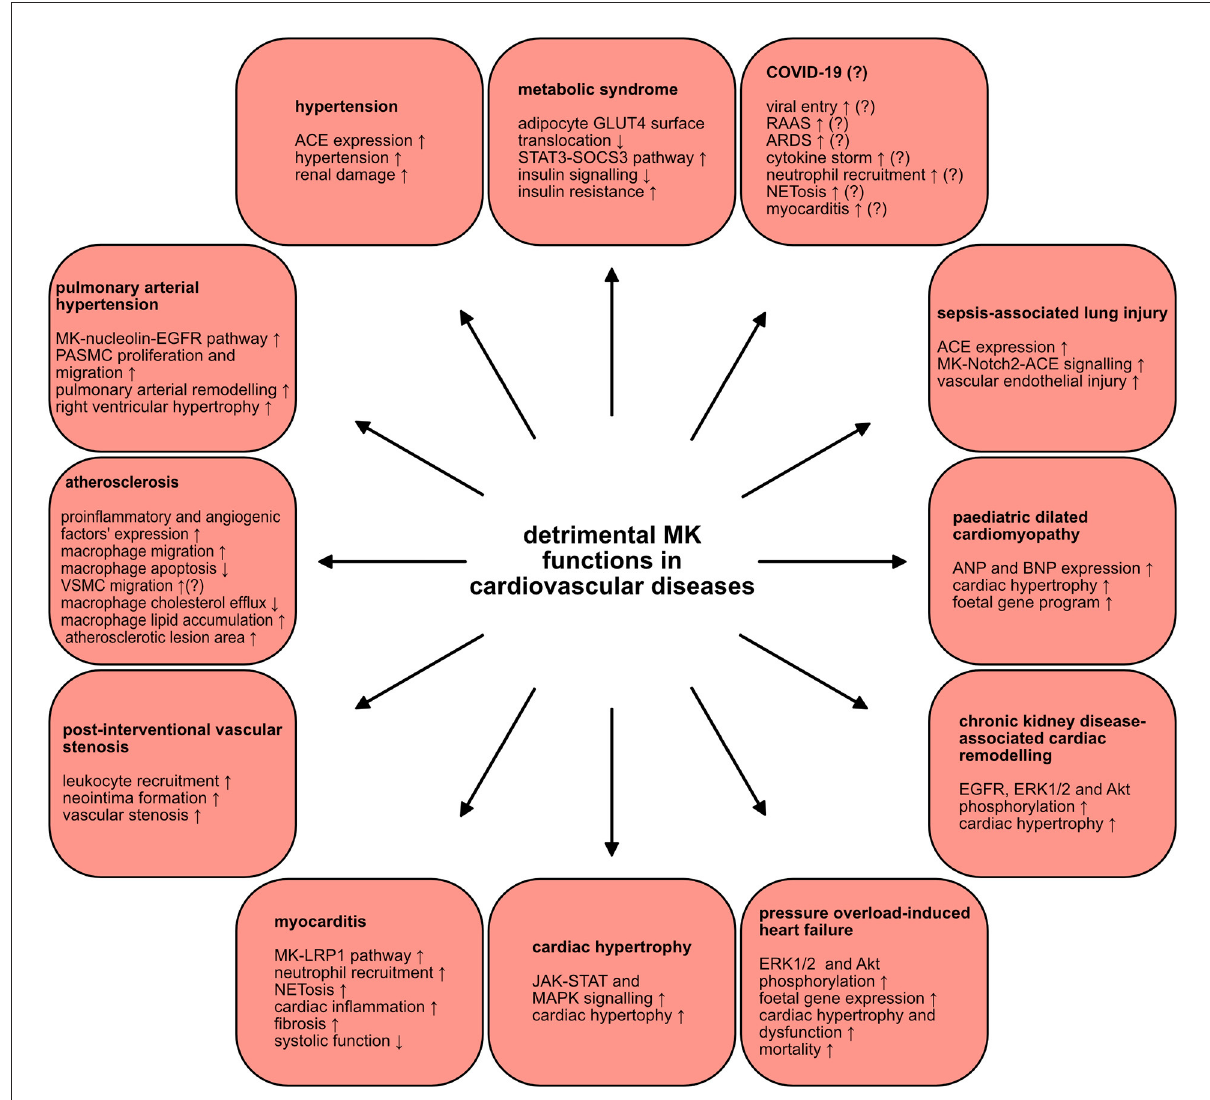
FIGURE3 Detrimental MK functions in cardiovascular diseases. MK plays injurious roles in a wide scope of cardiovascular diseases. The various mechanisms and signaling pathways through which MK negatively contributes to the pathogenesis of several cardiovascular diseases are